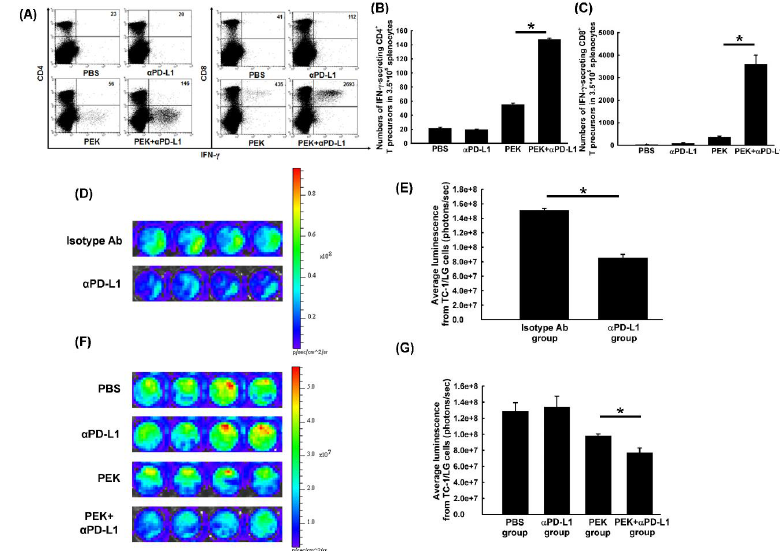
Figure 2. Antigen-specific immunoprofiles of mice treated with PEK protein vaccine with or without anti-PD-L1 Ab, and in vitro or ex vivo tumor-specific killing activities of antigen-specific CD8 + cytotoxic T cells or splenocytes from various immunized groups. ( A ) Representative figures of E7-specific IFN- γ -secreting CD4 + helper or CD8 + cytotoxic T cell precursors / 3.5 × 10 5 splenocytes on day 28 after tumor challenge in various vaccinated groups, as determined by flow cytometry analysis. ( B ) Bar figures depict the number of E7-specific IFN- γ -secreting CD4 + helper T cell precursors / 3.5 × 10 5 splenocytes on day 28 after tumor challenge in various groups, as determined by flow cytometry ( n = 5 per group, mean ± SEM). Mice treated with the PEK protein vaccine combined with anti-PD-L1 Ab had significantly higher numbers of E7-specific CD4 + T cell precursors than the other groups (*: p < 0.001, Student’s t -test). ( C ) Bar figures depict the number of E7-specific IFN- γ -secreting CD8 + cytotoxic T cell precursors / 3.5 × 10 5 splenocytes on day 28 after tumor challenge in various groups, as detected by flow cytometry ( n = 5 per group, mean ± SEM). The number of E7-specific CD8 + T cell precursors was highest in mice treated with the PEK protein vaccine combined with anti-PD-L1 Ab (*: p = 0.002, Student’s t -test). All experiments were performed independently in triplicate. ( D ) Representative figures of the in vitro tumor-specific killing activities of E7-specific CD8 + cytotoxic T cells treated with or without anti-PD-L1 Ab. ( E ) Quantitation of the average luminescence of TC-1-LG cells from mice in various treatment groups. The T cells from mice treated with anti-PD-L1 Ab exhibited lower luminescence than those from mice not treated with anti-PD-L1 Ab (*: p < 0.001, Student’s t -test). ( F ) Representative figures of the ex vivo tumor-specific killing activities of splenocytes from mice on day 28 after tumor challenge in various groups. ( G ) Quantitation of the average luminescence of TC-1-LG cells co-cultured with splenocytes from mice on day 28 after tumor challenge in various treatment groups ( n = 5 per group, mean ± SEM). Splenocytes from mice treated with PEK protein vaccine plus anti-PD-L1 Ab exhibited lower luminescence than splenocytes from mice treated with the PEK protein vaccine plus PBS (*: p = 0.017, Student’s t -test). All experiments were performed independently in